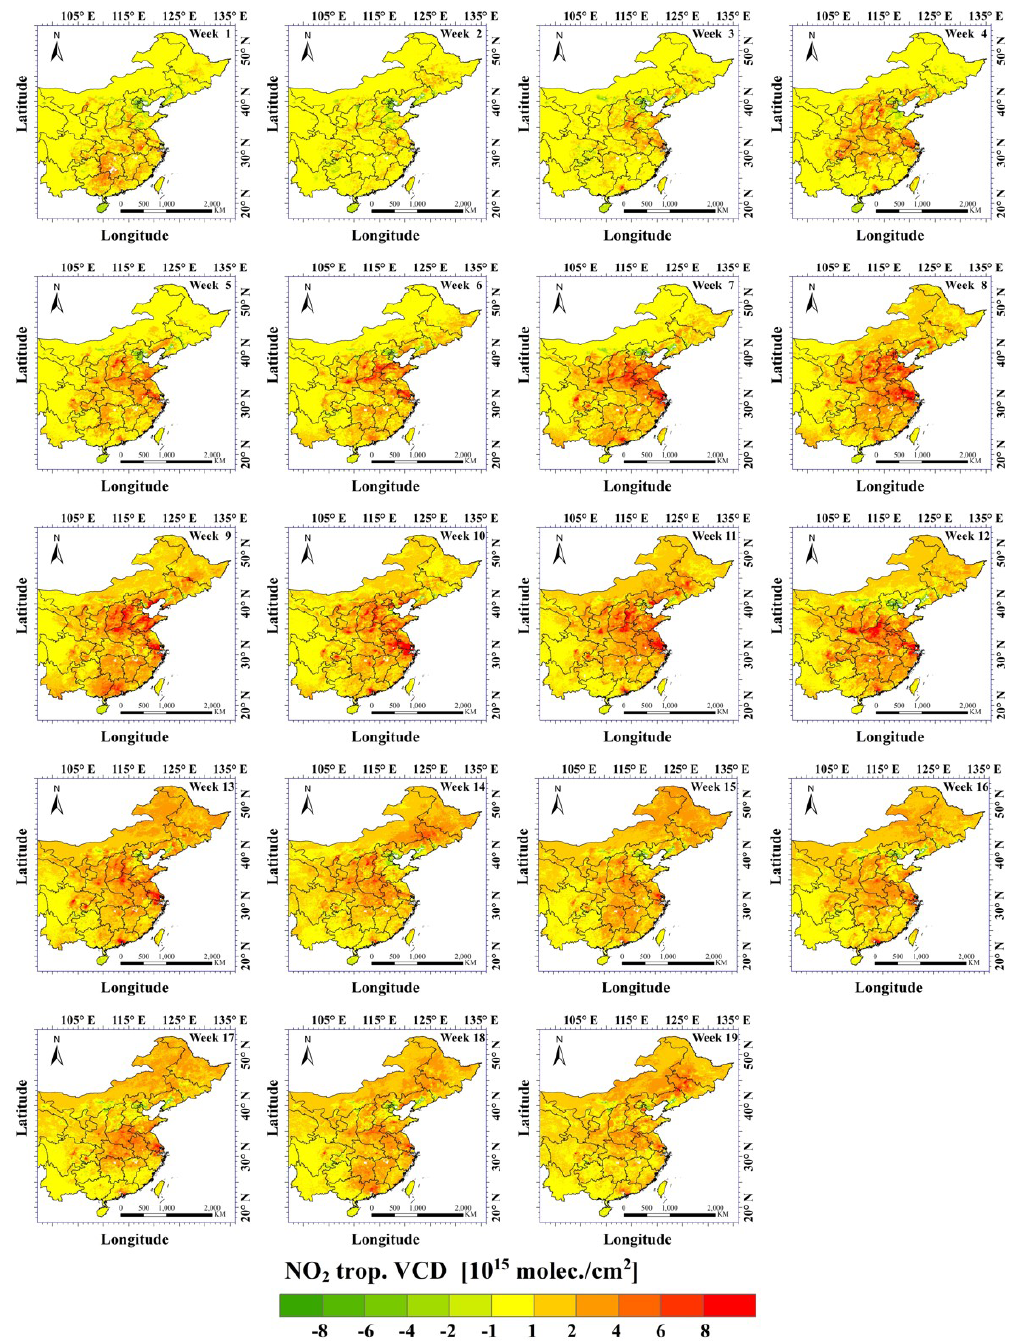
Figure A3. Difference plots for weekly averages of NO 2 TVCDs minus that for week 0 (Fig. 5) for weeks 1–19. Note that week number refers to the 2020 Spring Festival, i.e., week 0 starts on Saturday 25 January 2020. As explained in Sect. 2.1, the yellow background in the maps indicates no changes with respect to week 0, red indicates an increase and green indicates a decrease of the NO 2 TVCD.